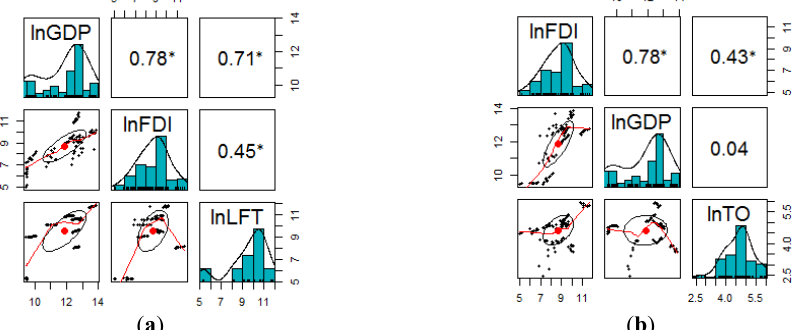
Fig. 5. Scatterplot matrix of variable relationships in structural equations: ( a ) lnGDP; ( b ) lnFDI. Source: primary data processed with the R